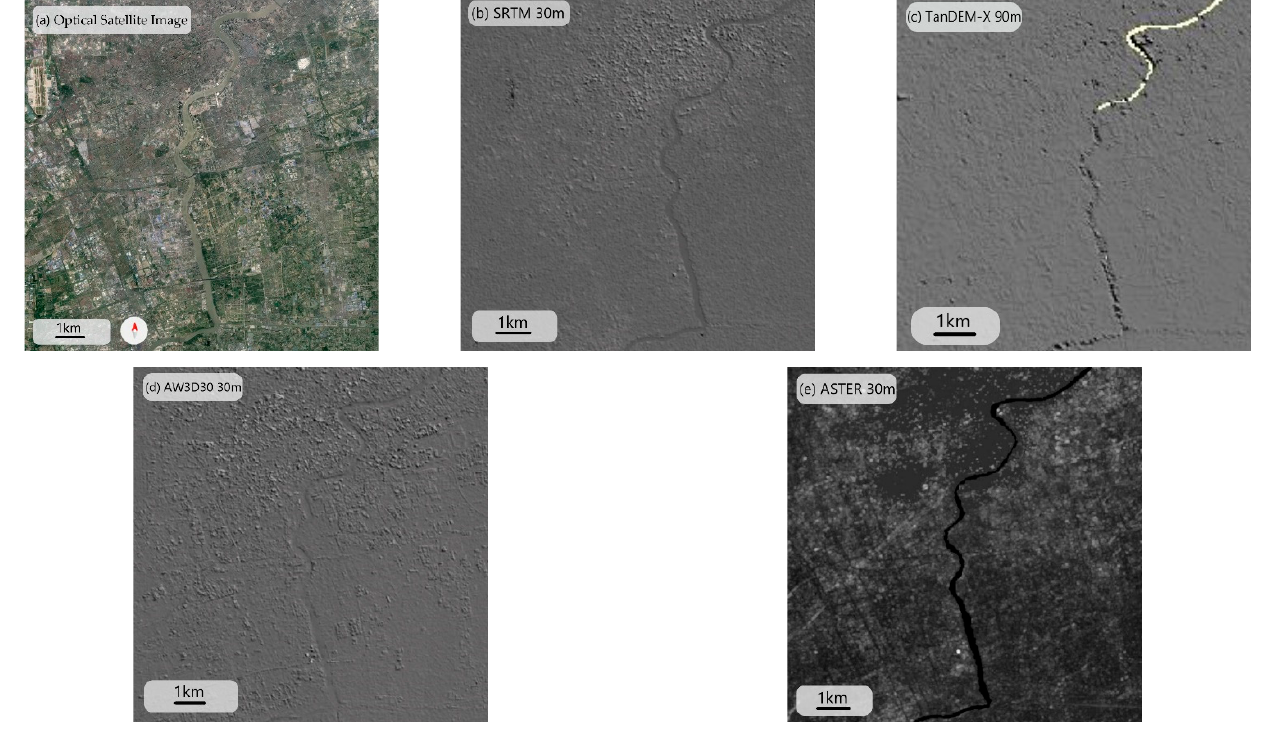
Figure 1. Schematic of the four digital elevation models (DEMs) and an optical satellite image of the Pudong study area (31°N, 121°E) obtained by Google Earth: ( a ) optical satellite image, ( b ) SRTM, ( c ) TanDEM-X, ( d ) AW3D30, and ( e ) ASTER.